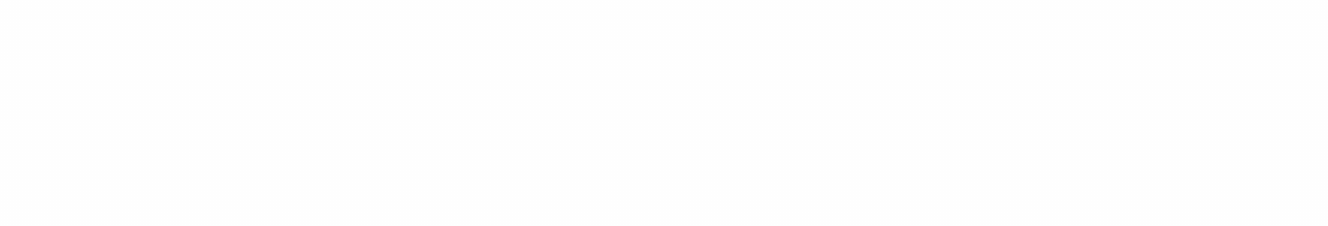
FIGURE 9 Percentage deviation of the position of the track finder with respect to the radius of the leader’s path. The minimum around PL 0.3 shows that the track finder opti- mally follows the leader’s path in the situation where the coordination of the collective movement is